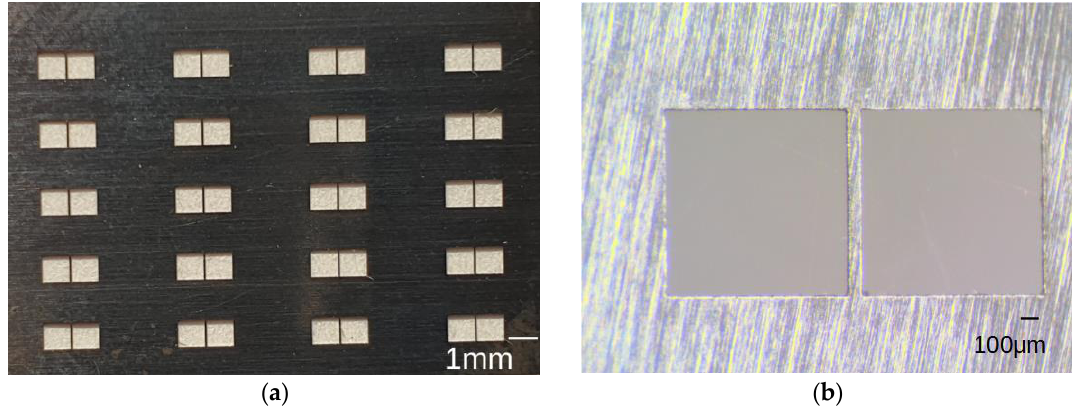
Figure 4. Microscopic photos of test structures—70 µm wide bar—hardened steel 1.1274, 30 µm: ( a ) magnification 5×; ( b ), magnification ×300.